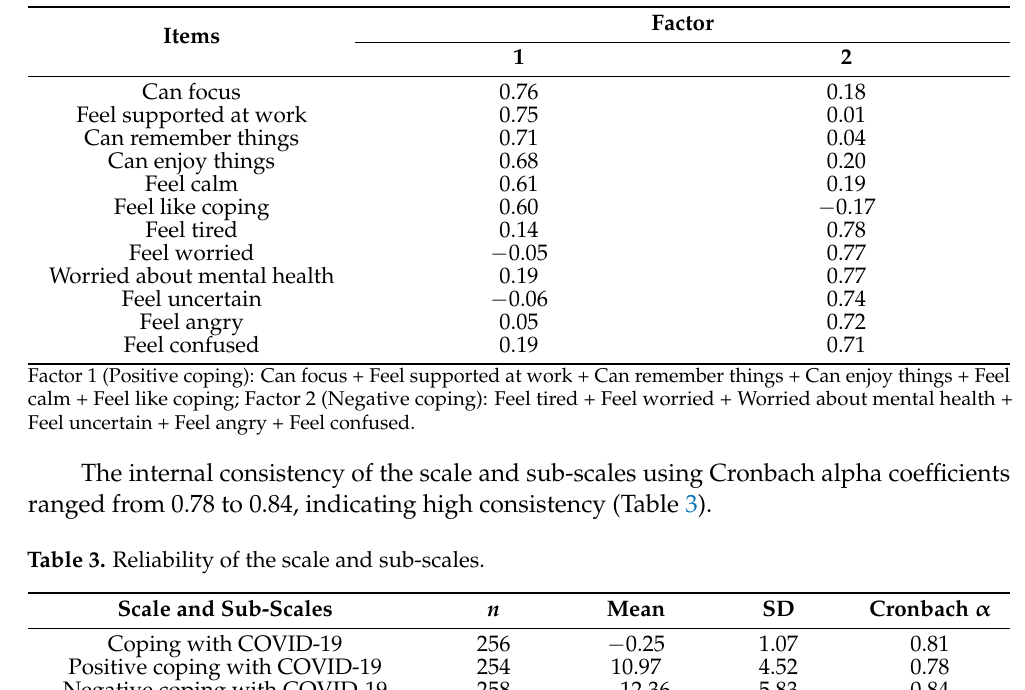
Table 2. Principal component analysis—factor loadings.